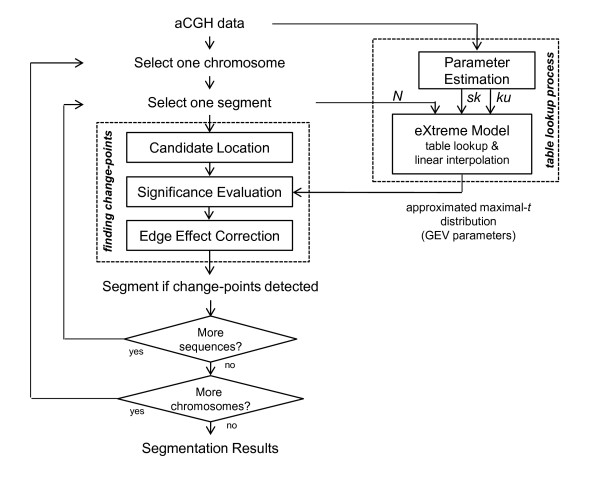
The block diagram of eCBS. The block diagram demonstrates how eCBS works. The parameter N refers to the number of probes in the sequential data under consideration; the parameters sk and ku refer to the estimates of skewness and kurtosis, respectively, from the aCGH data.